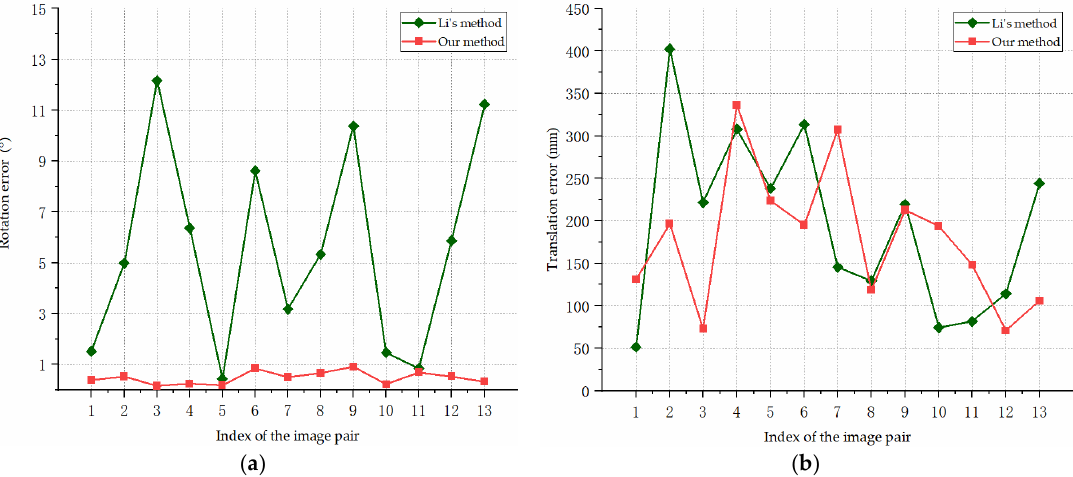
Figure 13. Pose estimation errors for the simulated images of Model 1: ( a ) Rotation errors; ( b ) Translation errors.